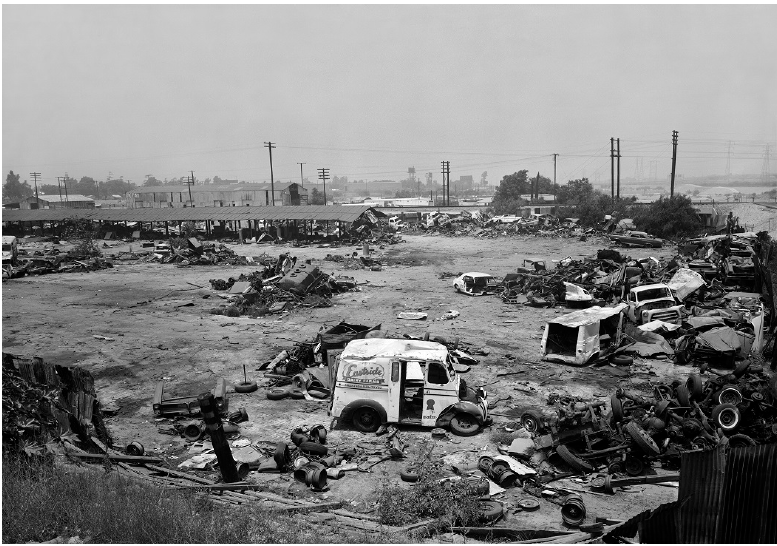
Figure 15. Anthony Hernandez, Automobile Landscapes # 35 (1978), © Anthony Hernandez.